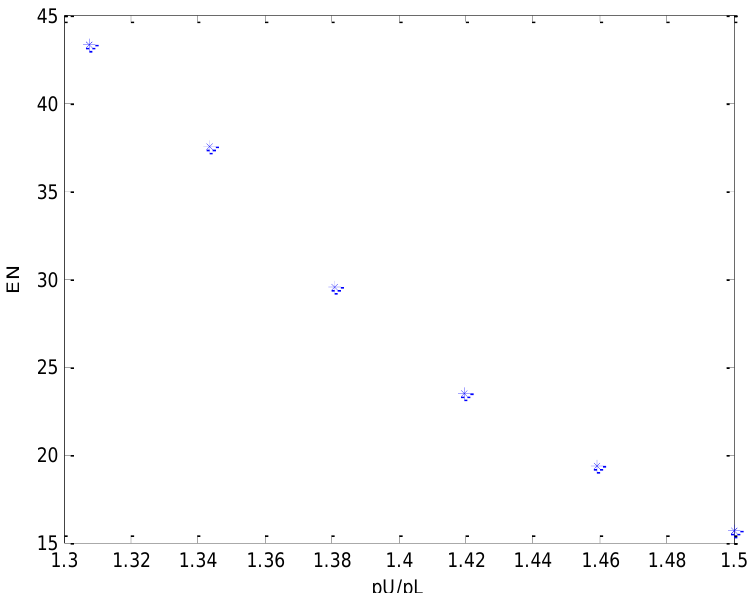
Fig. 8. The required expected number of tests versus the discrimination factor: ( p U =0.9, p L =0.6) to ( p U =0.85, p L =0.65) ; α=0.05,